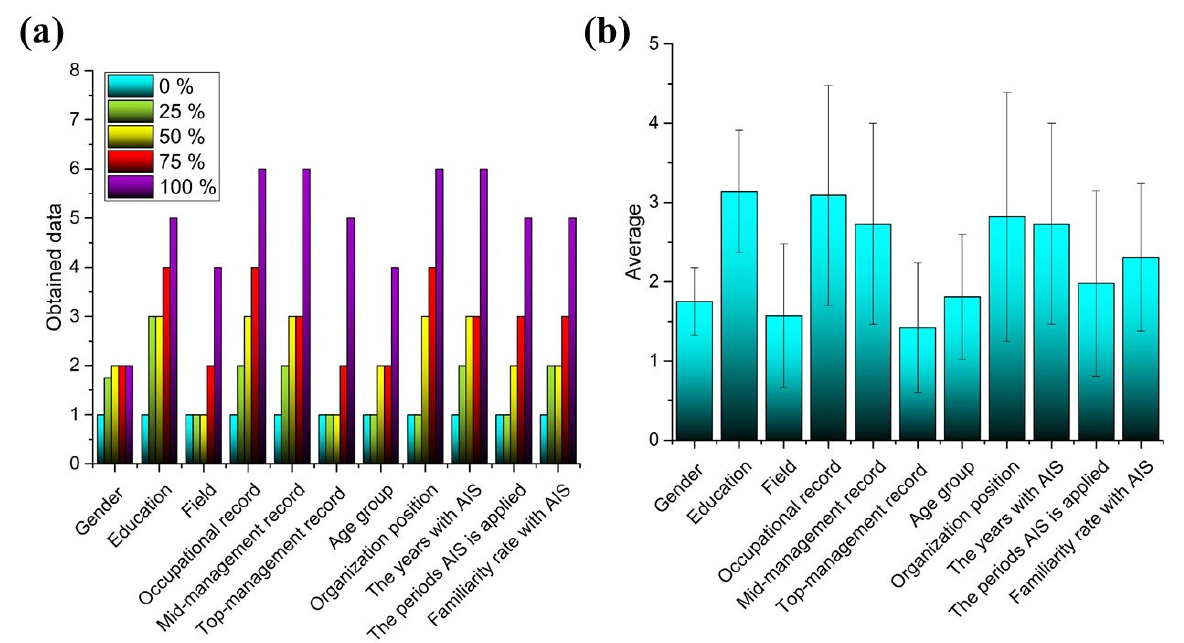
Figure 3. ( a ) The obtained data and ( b ) their calculated average for 11 evaluated features. The two criteria of correlation coefficient and RMSE were applied to evaluate the models and scale the inputs and outputs before entering the AI models. Given that the entry parameters contained different scales, they were standardised within a specific − 1 and +1 range. The dispersion of each variable is shown in Figure 4. The correlation coeffi ‐ cient of the 11 features were tested through the human actor variable in Figure 5, indicat ‐ ing appropriate reliability.